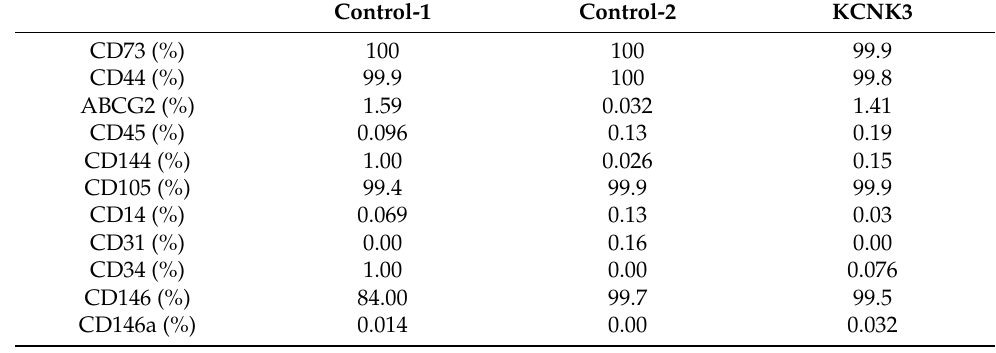
Table 1. Cell surface markers of iPS cells by flow cytometry. Inducible pluripotent stem cells (iPS) developed from healthy volunteers and KCNK3-HPAH patients were assessed for their mesen- chymal property by flow cytometry. CD73, CD44, CD105 and CD146 are the positive markers demonstrating mesenchymal property.